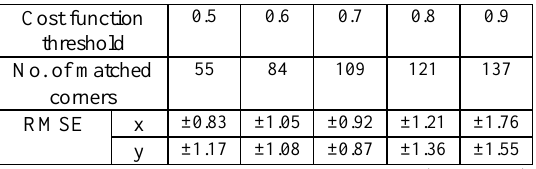
Table 2. The impact of cost function threshold (unit: